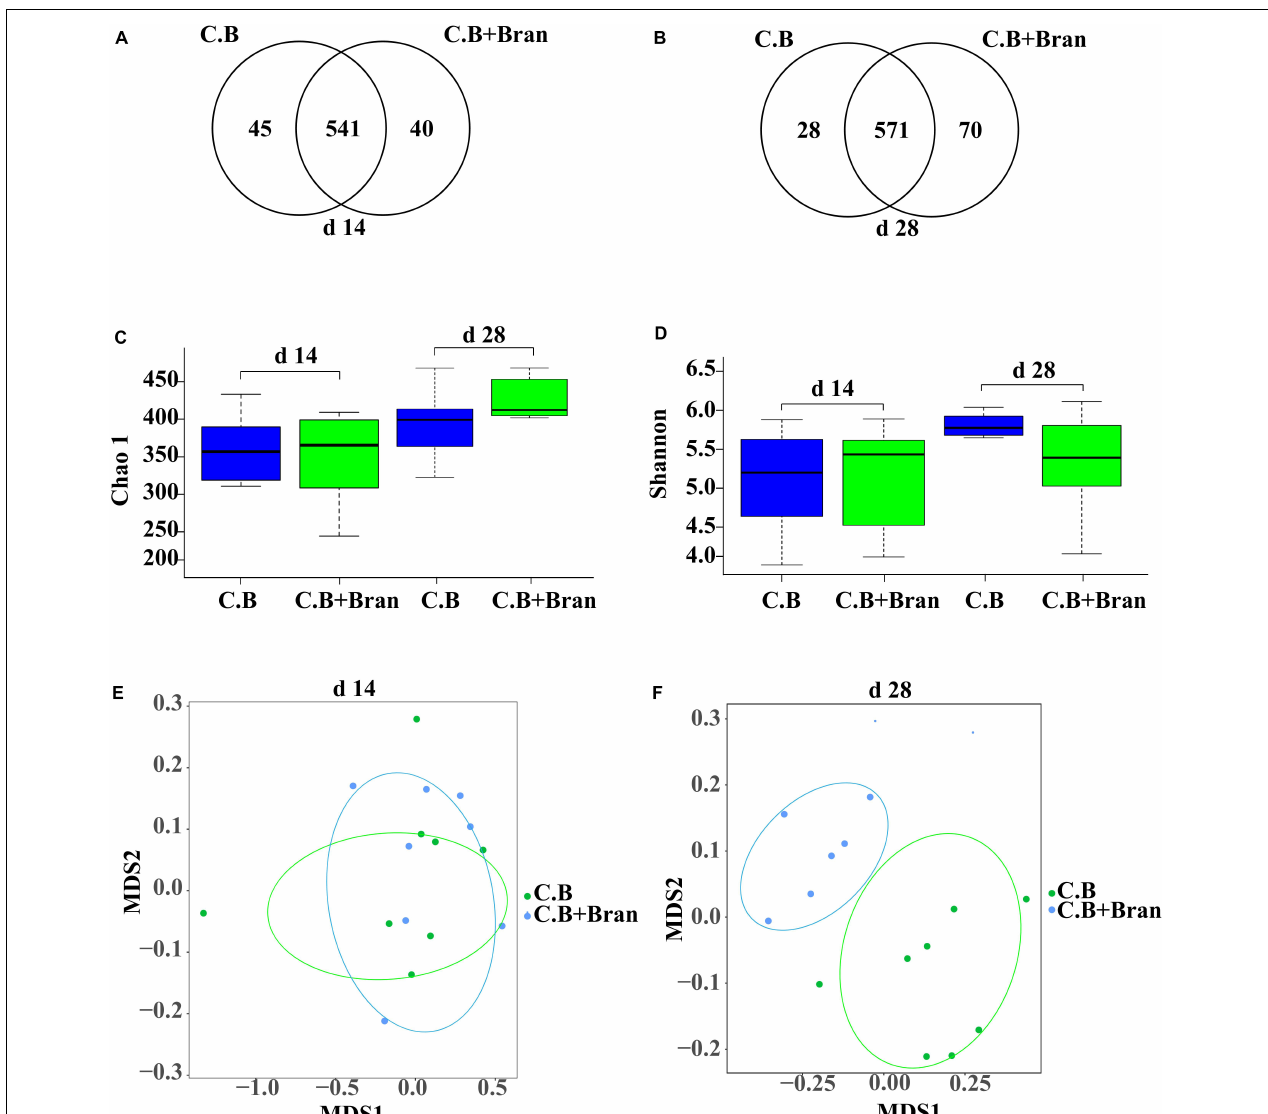
FIGURE 1 | Richness, diversity, and similarity of bacterial communities between different dietary treatments in weaned pigs. Venn diagram of the OTUs in basal diet with C. butyricum ( C.B ) group and basal diet with the combination of C. butyricum and corn bran ( C.B + Bran) group at the 14th day (A) and 28th day (B) after weaning. Bacterial richness was estimated by the Chao1 value (C) . Bacterial diversity was estimated by Shannon index (D) . The diff-NMDS plot comparative analysis of sample in bacterial community between two groups were showed on day 14 (E) and 28 (F) after weaning.